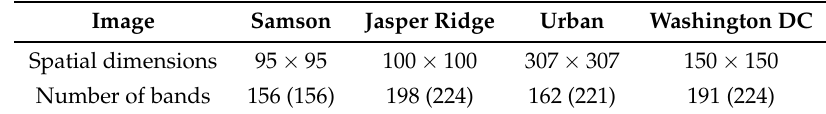
Table 1. Spatial dimensions and number of bands (in parentheses, the number of total bands) of each hyperspectral test